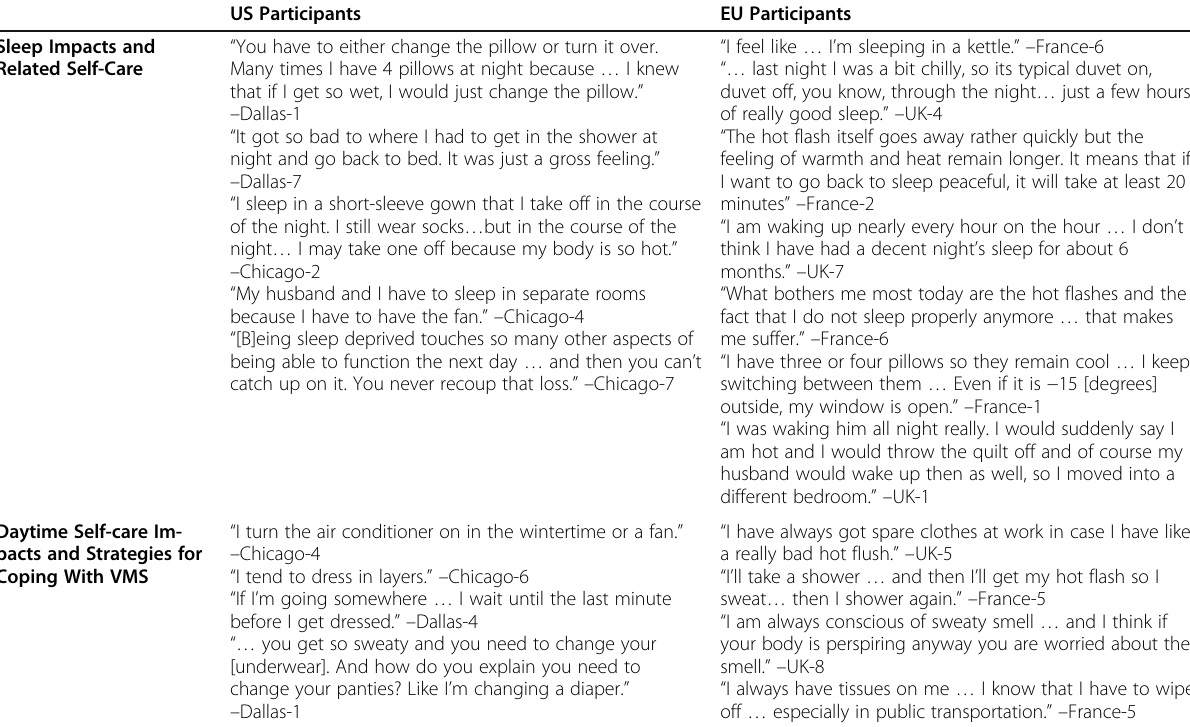
Table 5 Representative quotations from concept elicitation phase on sleep impacts and